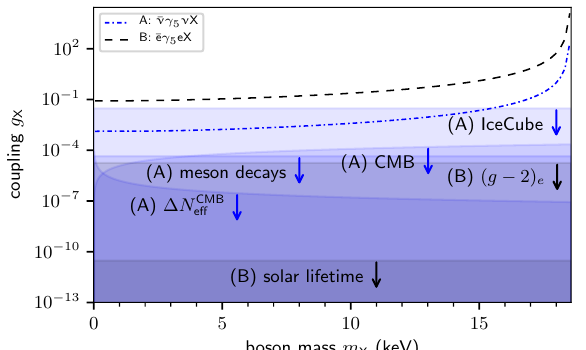
Figure 9 . Purely statistical sensitivity contours for keV-scale light pseudoscalar bosons. Shown is the 90 % C.L. statistical sensitivity of a Katrin differential spectrum measurement with a new de- tector system. Furthermore, the shaded areas mark the parameter regions allowed from constraints discussed in section